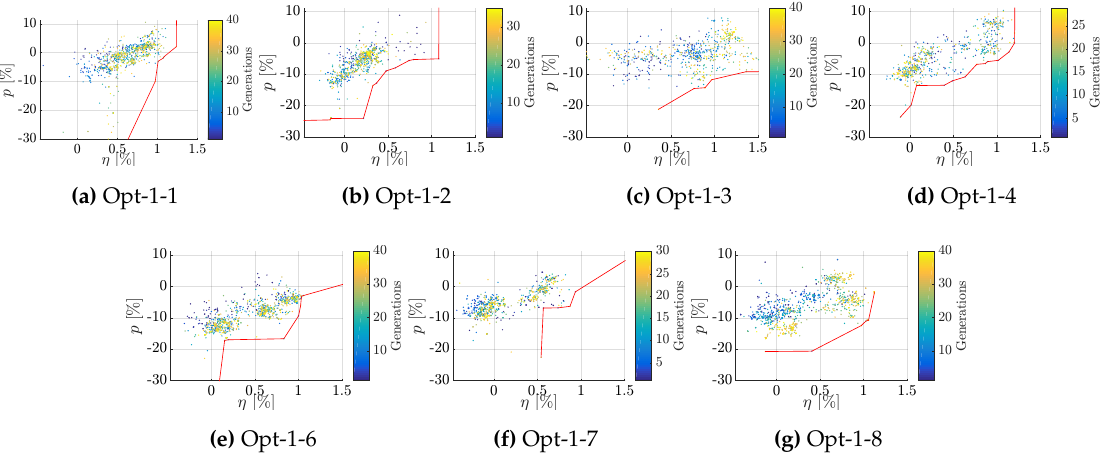
Figure A2. Pareto fronts for Opt-1 for η and pressure pulse objectives (Group 1: ( a – d ); Group 2: ( f – g